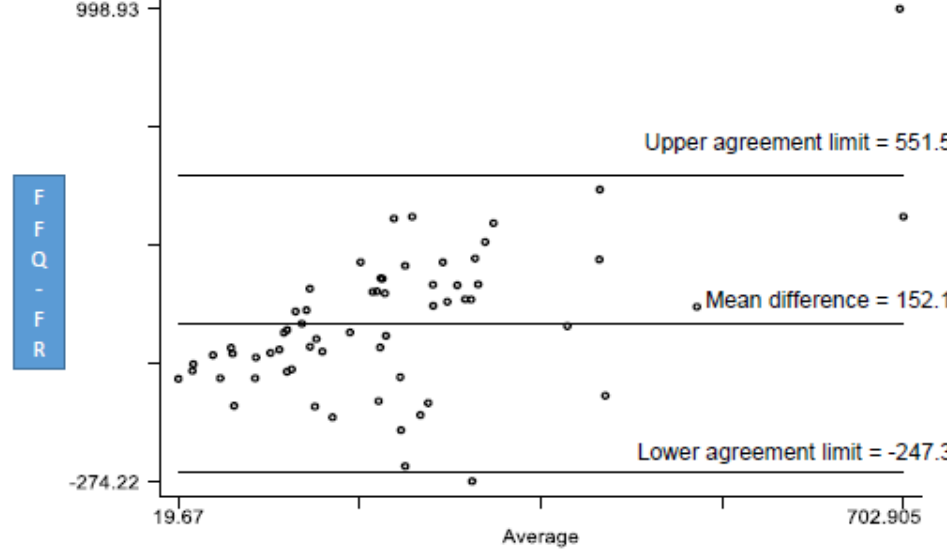
Figure 1. The Bland-Altman (BA) plot showing “differences in mean daily vitamin D intake between food frequency questionnaire (FFQ) and three-day food records (three-day FR)’ against the average daily vitamin D intake of FFQ and three-day FR”. Only two out of 62 fell out of lower and upper agreement limits, giving a BA index of ≈ 3.2%. Table 1. Quartile correlation of vitamin D intake from food frequency questionnaire and three-day food